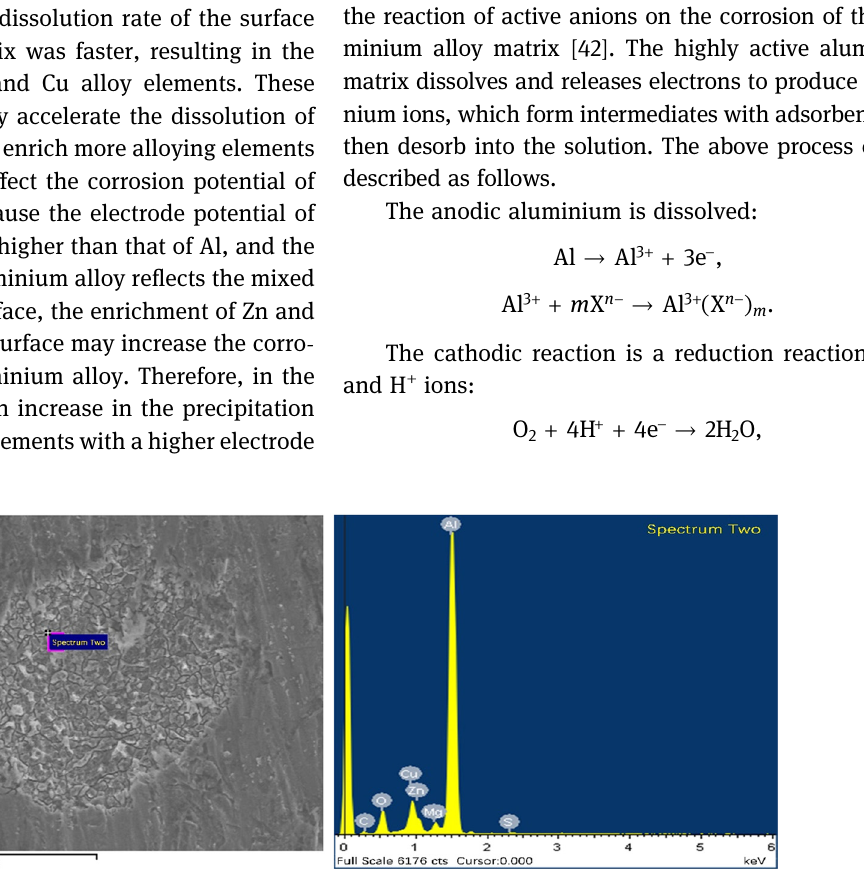
Figure 17: EDS analysis of simulated acid rain solution corrosion area of the aluminium alloy.